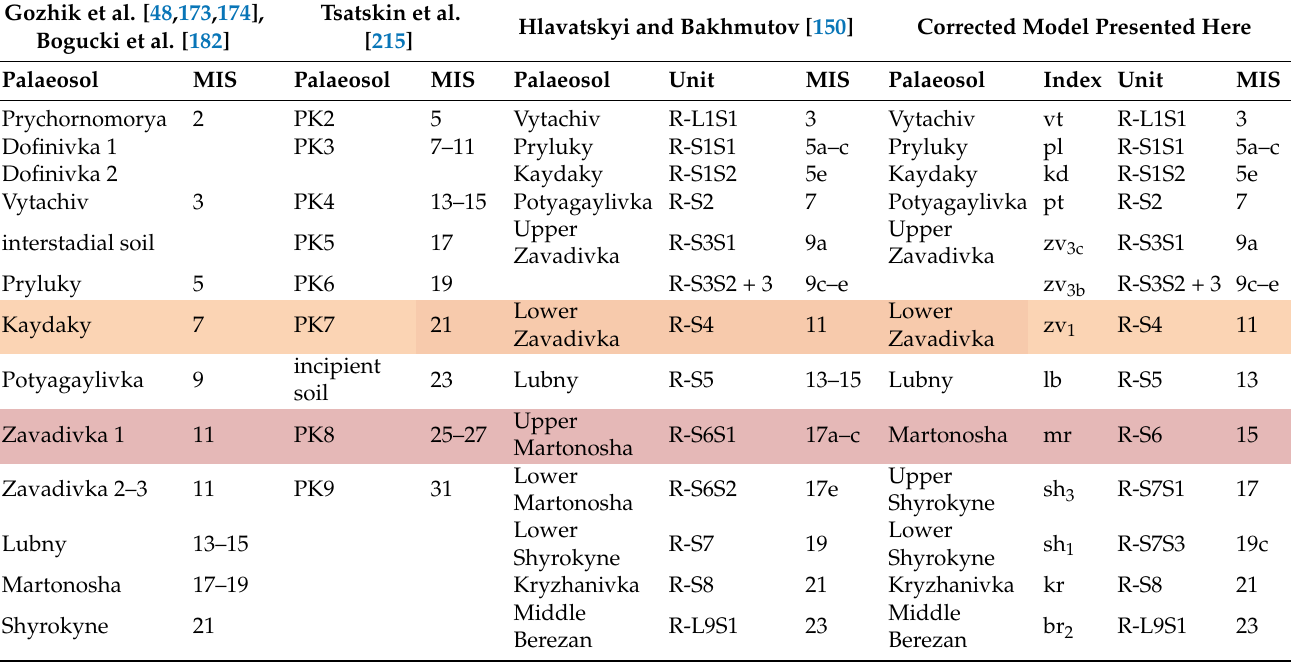
Table 2. Chronostratigraphic models proposed for the Roksolany loess sequence.